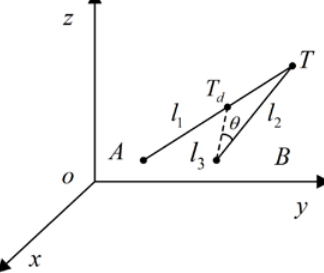
Fig. 2. Location schematic when the measurement is